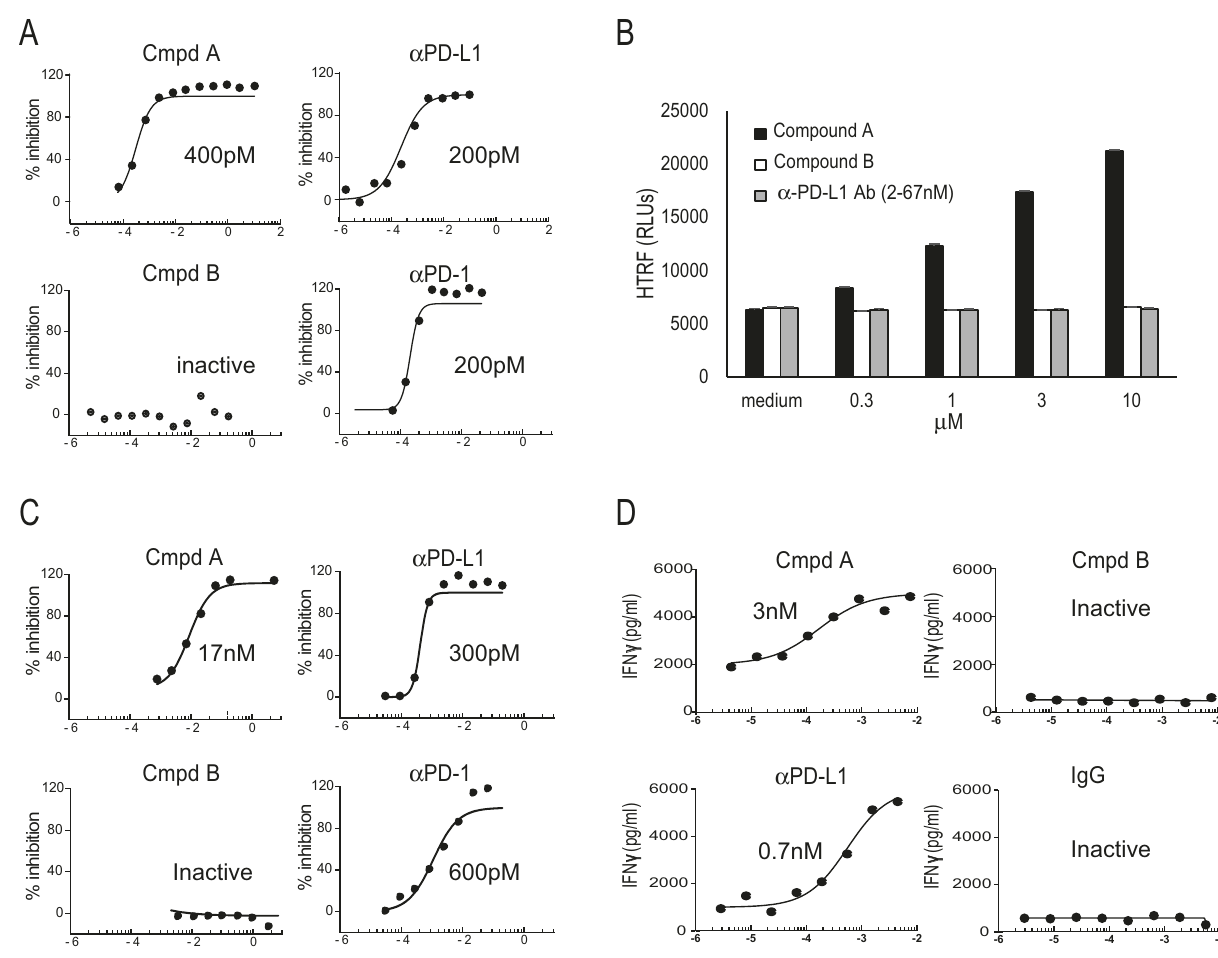
Fig. 1 In vitro and ex vivo inhibition of PD-1/PD-L1 interaction. a PD-1/PD-L1 homogenous time-resolved fl uorescence (HTRF) assay. b PD-L1/PD-L1 HTRF dimerization assay. c PD-1/PD-L1 NFAT reporter bioassay. d CMV recall assay: IFN γ production measured by ELISA following stimulation of PBMCs with CMV antigens. Source data are provided as a Source data fi